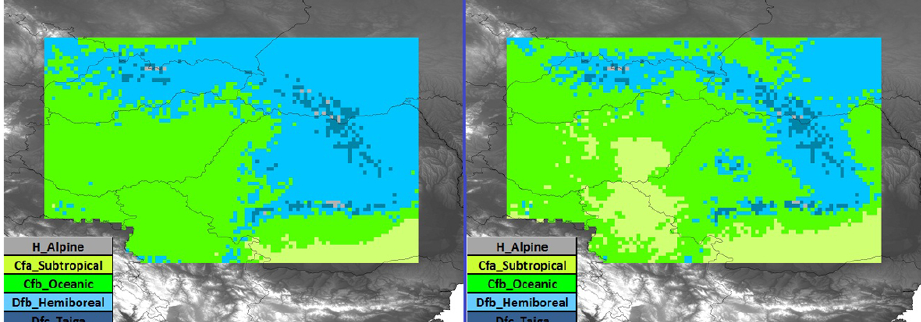
Figure 7. K¨oppen-Geiger climate maps of the Carpathians for 1961–1990 (left) and 1981–2010 (right).